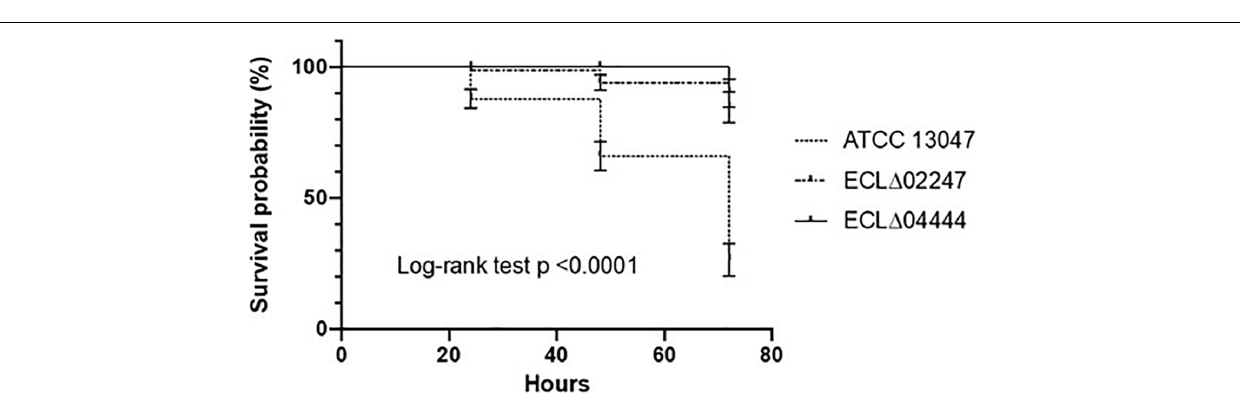
FIGURE 4 | Effect of gene deletions on virulence. Percent survival of G. mellonella larvae over 72 h after infection with around 6 × 10 6 CFU of E. cloacae ATCC 13047, (cid:49) ECL_02247 mutant, and ECL (cid:49) 04444 mutant strain. Experiments were repeated at least three times, and the results represent the mean ± standard deviation of live